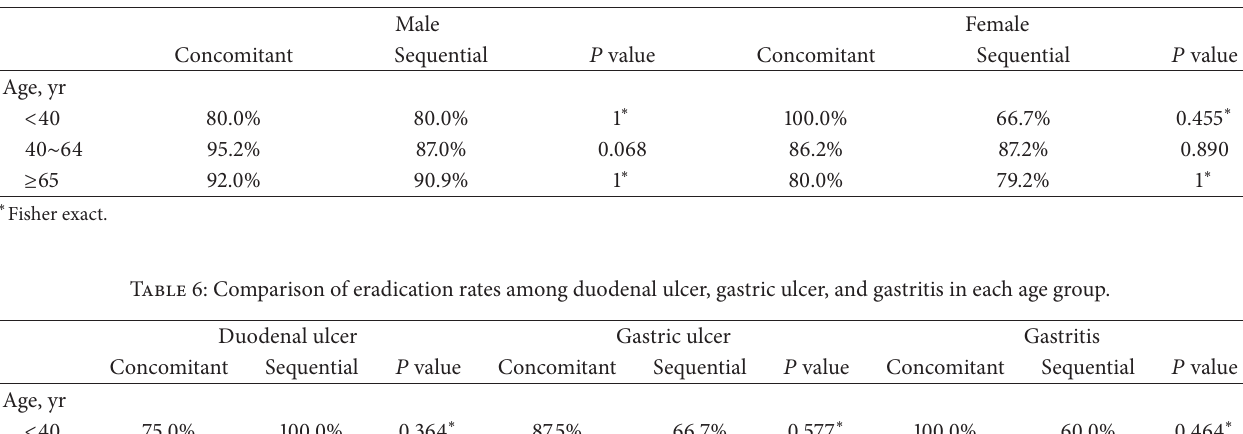
Table 5: Comparison of eradication rates between men and women in each age group.